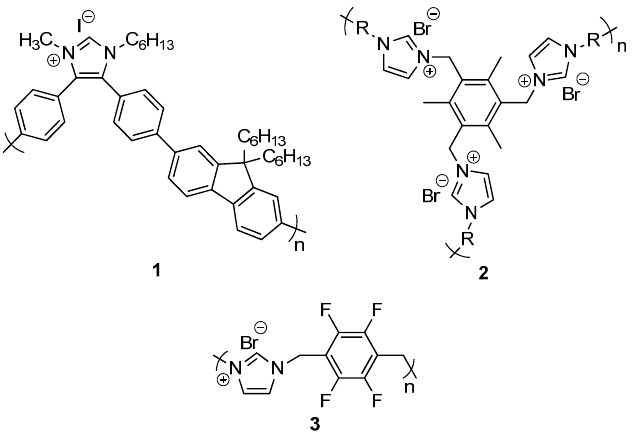
Figure 2. Examples of self ‐ supported imidazolium salts used as N ‐ hereocyclic carbene (NHC) precursors and catalysts. precursors and